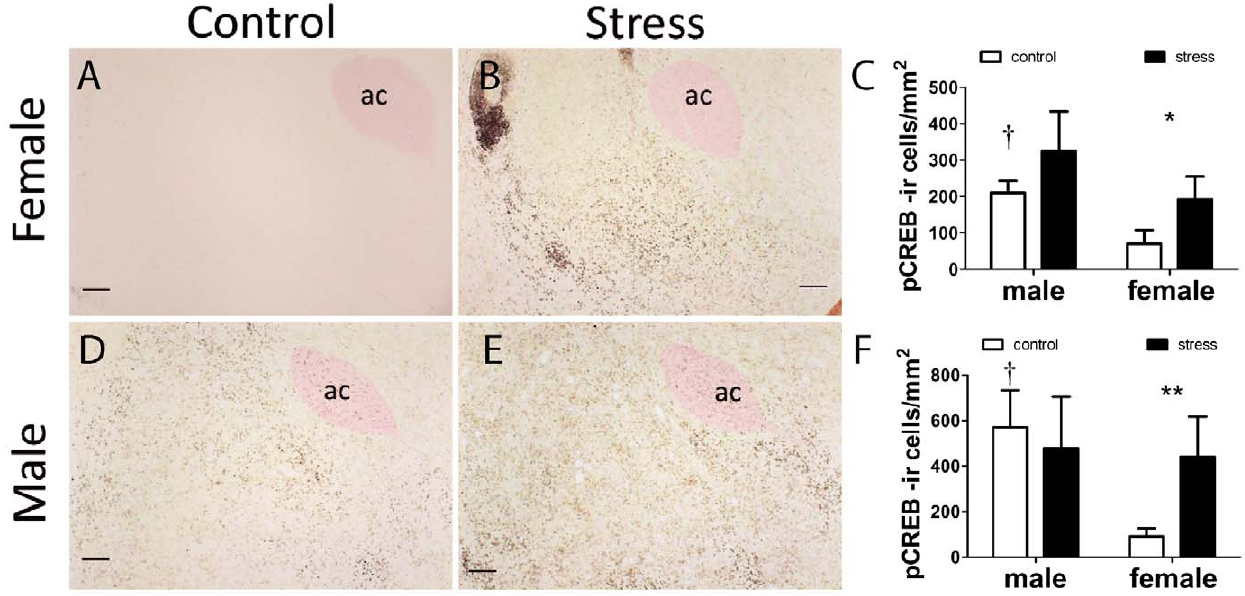
Figure 4. Immunostaining for phosphorylated CREB in female (A, B, C) and male (D,E, F) California mice after social interaction tests. Mice were exposed to three control or social defeat episodes. Social defeat increased the number of pCREB positive cells in females but not males in the NAc shell (C) and core (F). Control males generally had higher pCREB cell counts than control females. { Mann-Whitney sex difference in controls p , 0.05, *, **, Mann-Whitney effect of stress p , 0.05, p , 0.01 respectively. All data are mean 6 s.e. Anterior commissure, ac. Scale bars=100 m m. doi:10.1371/journal.pone.0017405.g004 PLoS ONE |